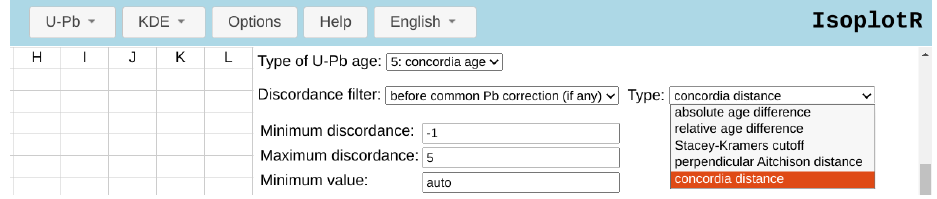
Figure B1. The new discordance filters can be accessed from IsoplotR’s graphical user interface, shown here under its kernel density estimation